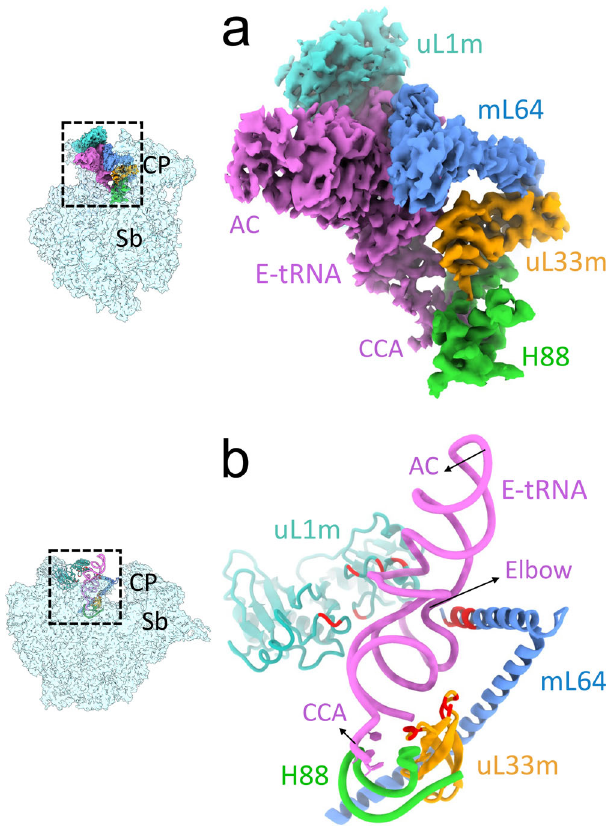
Fig. 4 Stabilization of the E-site tRNA on the dissociated 39S subunit. a Extracted cryo-EM densities corresponding to E-site tRNA and interacting 39S subunit components. The E-site tRNA (orchid) is stabilized on the 39S subunit through multiple interactions with the mitoribosomal components. The elbow region of the E-site tRNA is sandwiched between 39S MRPs uL1m (cyan) and the mitospeci fi c mL64 (blue) while the acceptor arm and the CCA end have strong interactions with uL33m and the 16S rRNA helix H88, respectively. b Atomic models for the densities shown in a . Multiple MRP segments bearing positively charged aa residues (Arg and Lys; red) interact with the negatively charged phosphates of the E-site tRNA molecule. To better display the location of the positively charged aa residues at the interface of tRNA and MRPs, the b orientation is obtained by applying an upward rotation around a horizontal axis to the panel a orientation. AC and CCA refer to anticodon and CCA ends of the tRNA. Thumbnails to the left depict an overall orientation of the 39S subunit (semitransparent blue), with overlaid highlighted mitoribosomal components and ligands. Landmarks on the thumbnail: CP central protuberance, Sb stalk